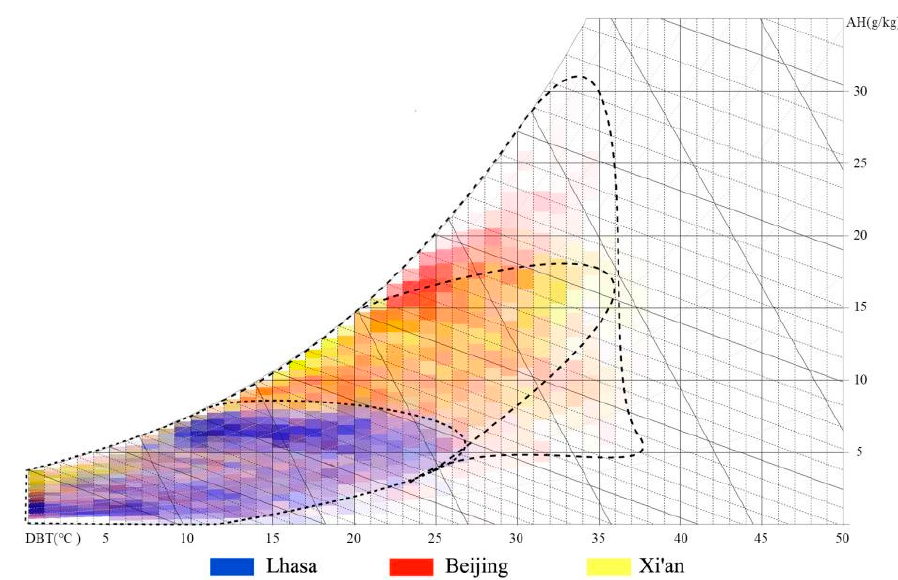
Figure 2. Enthalpy humidity diagram and solar radiation intensity comparison diagram of Lhasa, Beijing, and Xi’an (Adapted with permission from Ref. [33]. 2021, Chen, L.)